Question: Compose a caption that would accompany this figure in a paper.
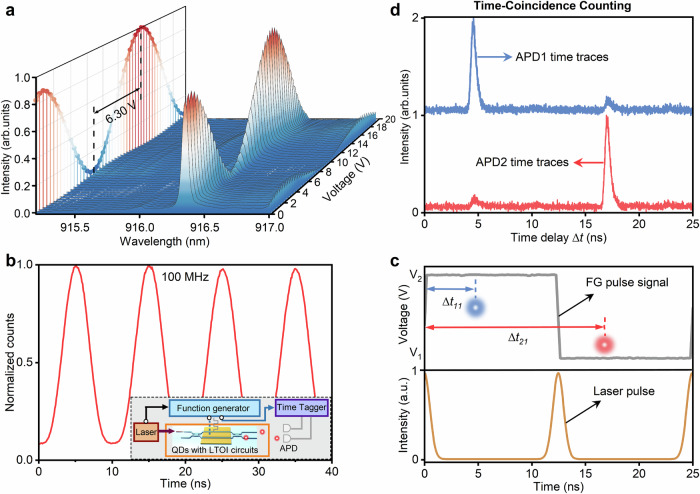
Answer: On-chip single-photon routing at cryogenic temperatures. a The spectra mapping of the QD’s emission under different voltages applied to the modulation electrode by a DC voltage source. The left panel presents the cryogenic electro-optic characterization, revealing the measured half-wave voltage. b Example of a sinusoidal modulation of a continuous-wave laser at 100 MHz at 4 K, demonstrating the device’s high-frequency response. The inset shows the experimental setup for on-chip single-photon routing. c The orange curve represents the pulsed laser output signal, while the gray curve indicates the rectangular wave signal synchronously output by the arbitrary function generator to the electrode. The blue and red photons denote their arrival times at the APD from different output ports, illustrating deterministic routing to distinct ports depending on the applied voltage. d Time traces showing the arrival of single photons at two separate output ports.